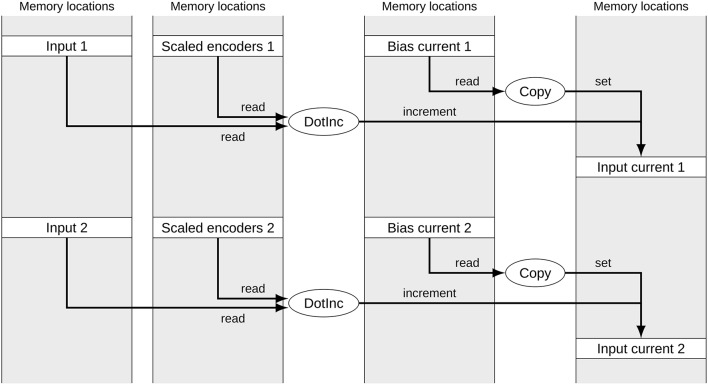
Signals and operators to calculate the input current to two neural groups. The gray boxes represent memory locations with allocated signals. Ellipses represent operators accessing and modifying these signals. Both sets of operators for the two neural groups access unrelated memory locations.